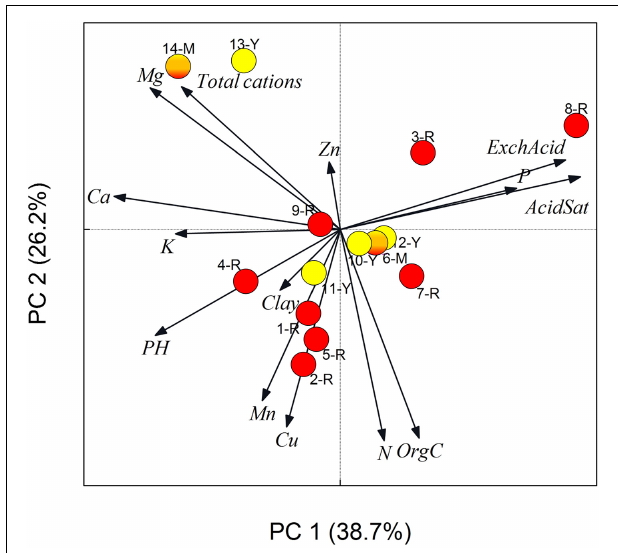
FIGURE 3 | Principal Components Analysis biplot with vectors overlaid showing relationships of Gerbera aurantiaca populations and soil chemical variation across 14 sampling sites. Dominant capitulum color (red, mixed and yellow) of the populations are indicated by the circles (population codes and details of chemical analyses are listed in Supporting information Supplementary Table 4